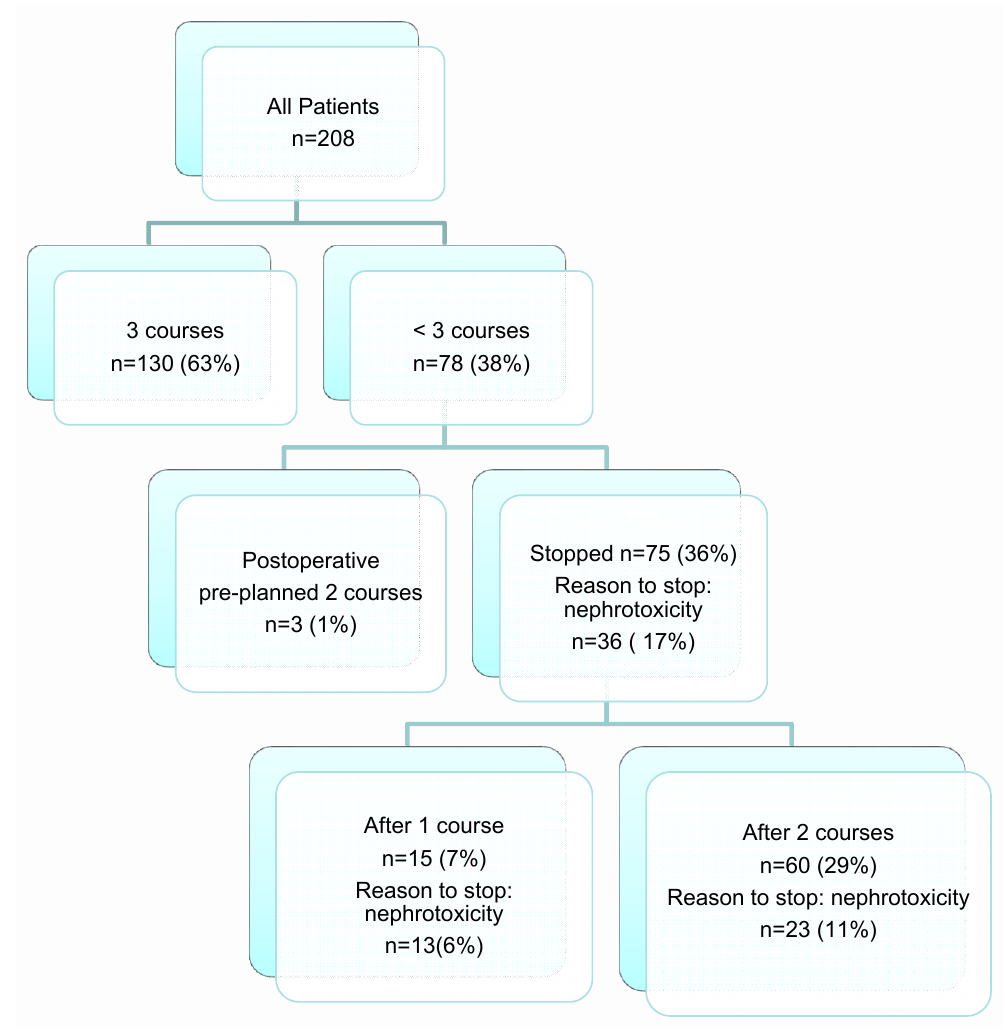
Figure 1. Treatment characteristics